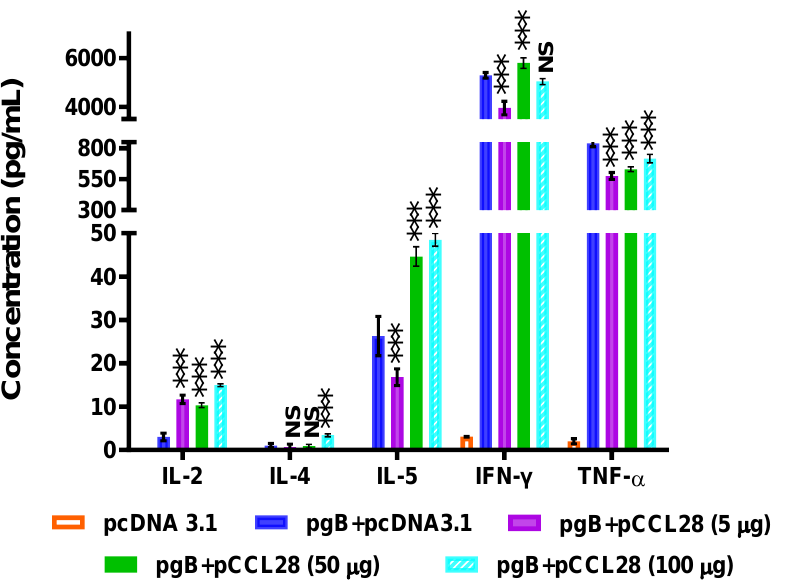
Figure 3. gB-specific Th1/Th2-related cytokine production. Comparison of cytokines produced by splenocytes in each group of mice ( n = 5/group). On day 14 post boost, splenocytes (1 × 10 7 cells) isolated from each immunized group were stimulated with purified gB (1 µ g/mL) and cultured for 5 days, and subsequently, the supernatants were collected for cytokine assessment using a CBA kit. The productions of Th1- (IL-2, IFN- γ , TNF- α ) and Th2 (IL-4, IL-5)-related cytokines are shown as the means of the cytokine concentrations (pg/mL) ± SEMs pooled from at least two independent experiments, with each condition performed in duplicate. The indicated p -values show statistically significant differences between the antigen group and the pgB + pCCL28 (5, 50 or 100 µ g) group, as determined by a nonparametric Student’s t -test. NS, not statistically significant; *** p <